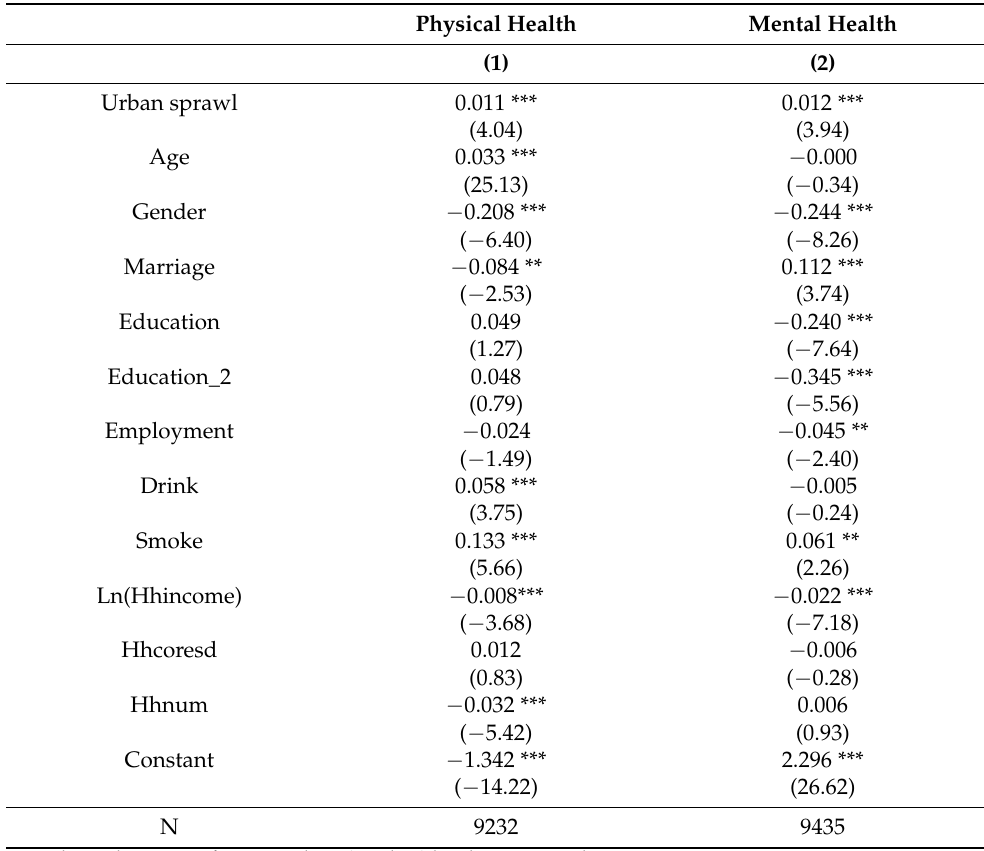
Table 2. Benchmark regression